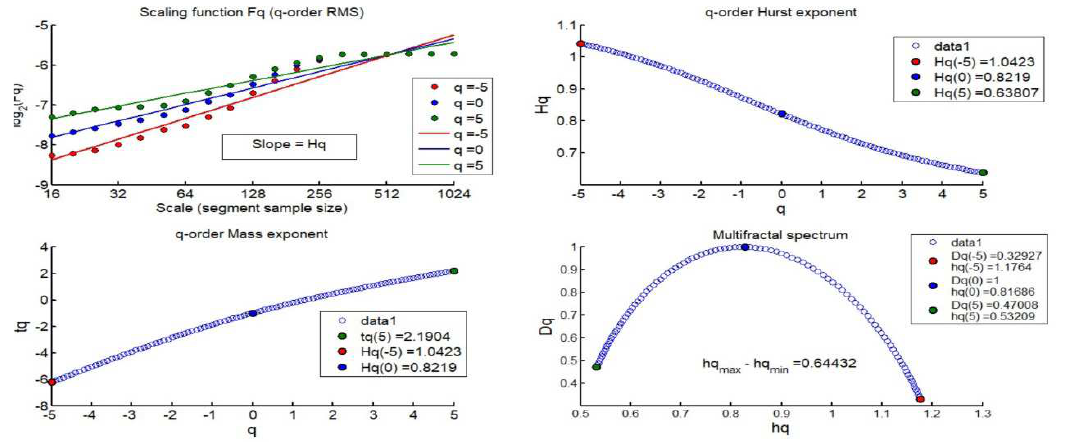
Figure A11. Hurst exponent value Hq (5) in